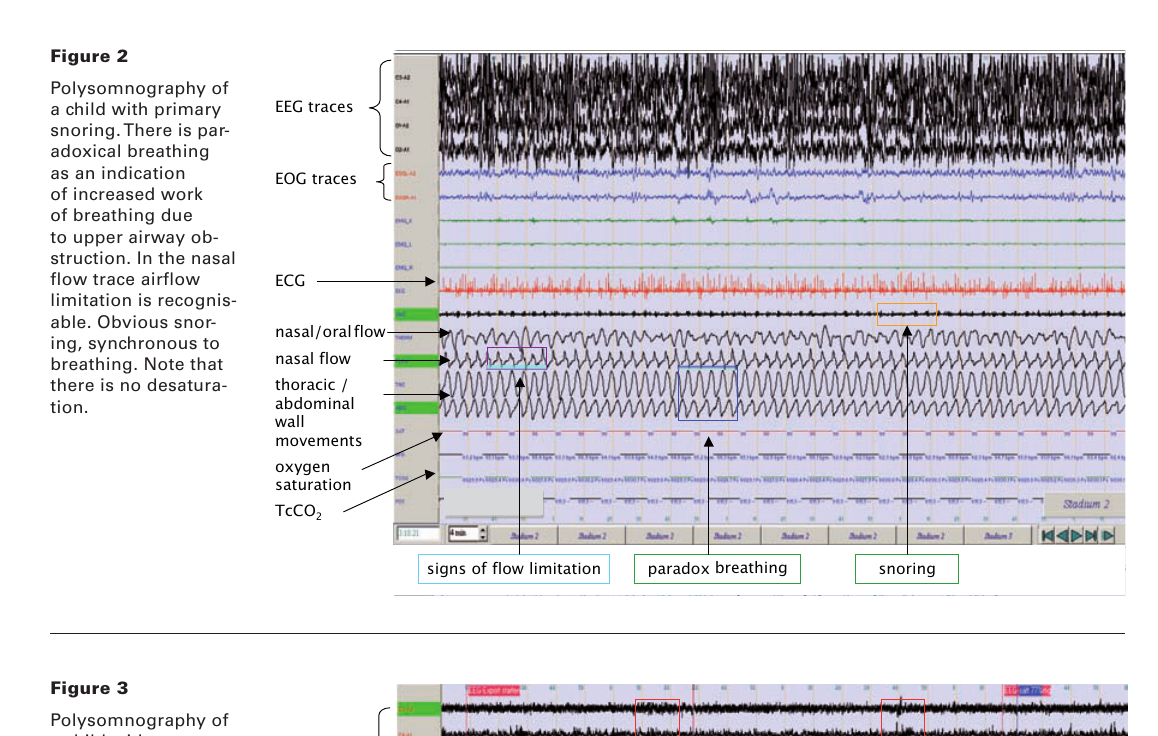
Figure 1 Polysomnography of a child with OSAS with frequent ob- structive apnoea and desaturations. There are four obstructive apnoeas with absent oral/nasal flow de- tected by a thermis- tor but ongoing tho- raco-abdominal ef- fort. Between the single obstructive apnoeas there is evident paradoxical breathing with tho- racic wall movements being discordant to the abdominal wall movements. A period of significant desatu- ration is indicated by a purple square.